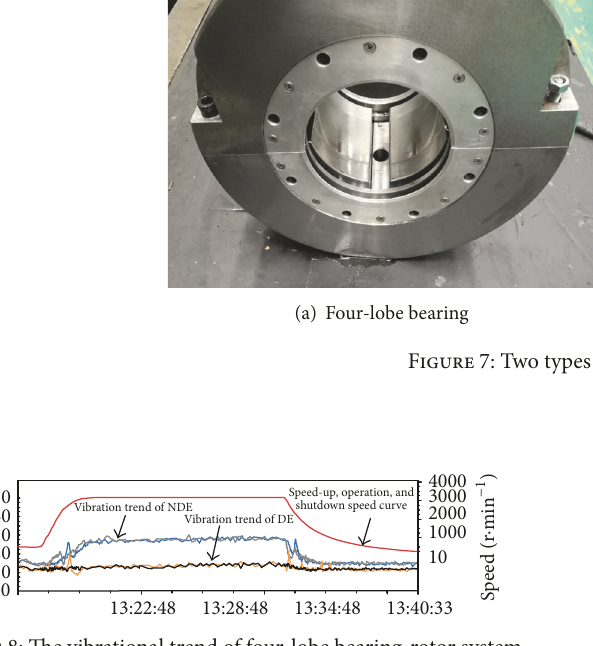
Figure 8: The vibrational trend of four-lobe bearing-rotor system.